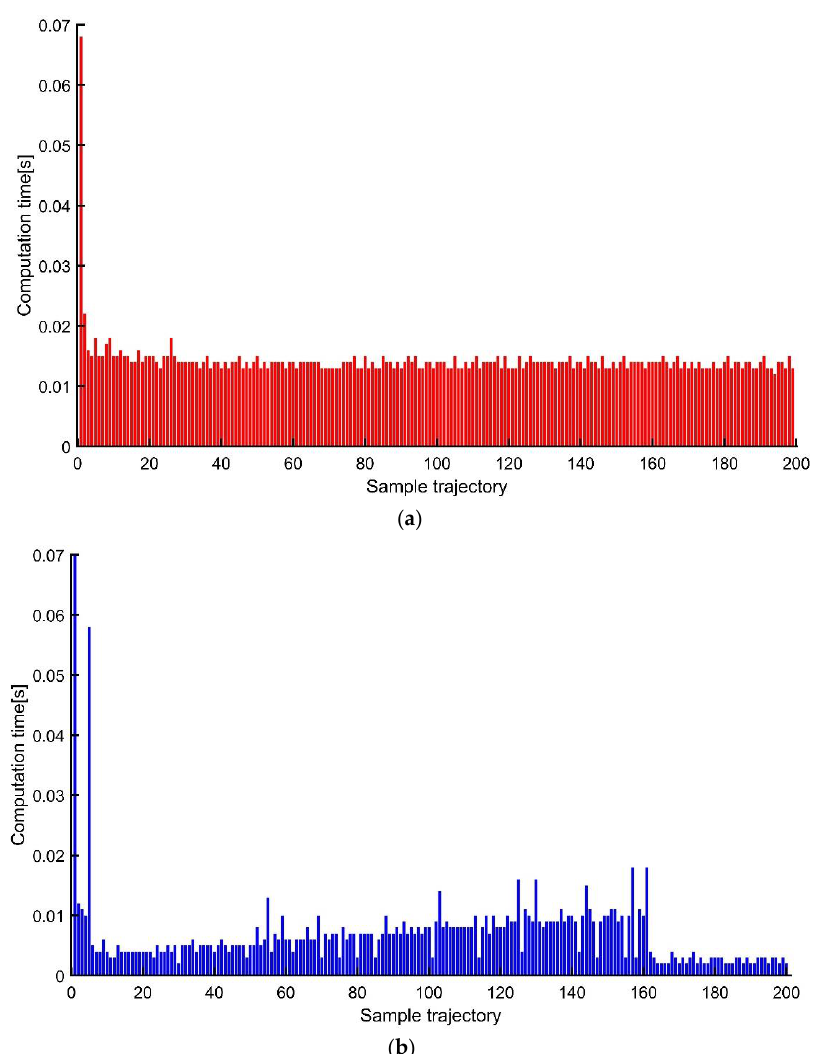
Figure 10. Computation time of the RBF-NMPC and LMPC: ( a ) Computation time of the RBF-NMPC; ( b ) Computation time of the LMPC. ( b ) Computation time of the